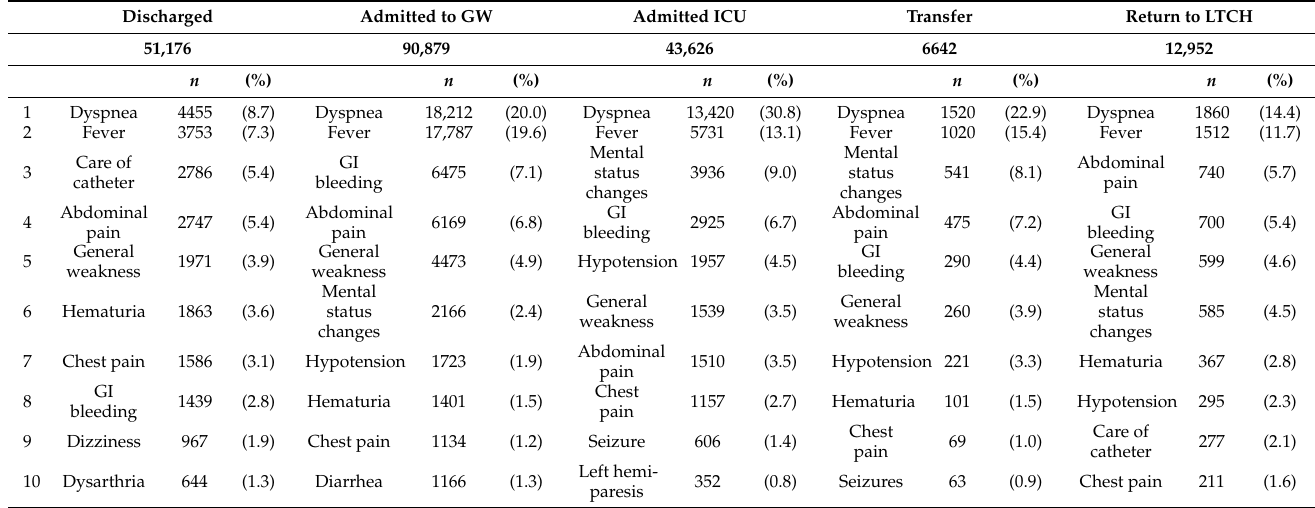
Table 4. Common chief complaints of patients from